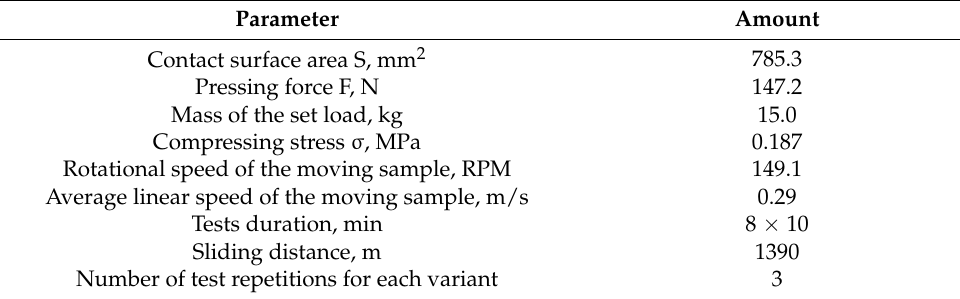
Table 2. Main parameters of the wear